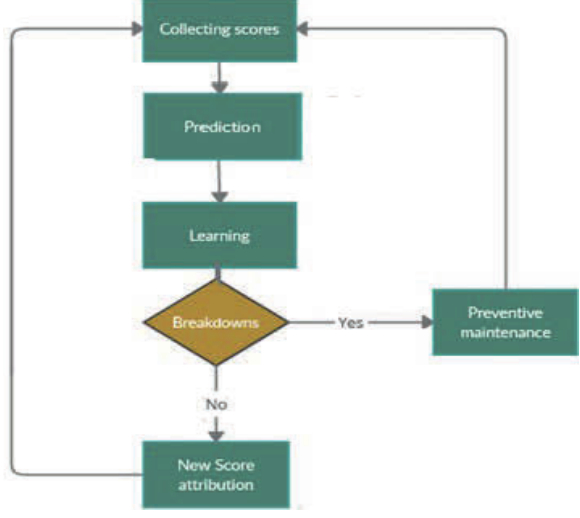
Fig. 4. Inside learning